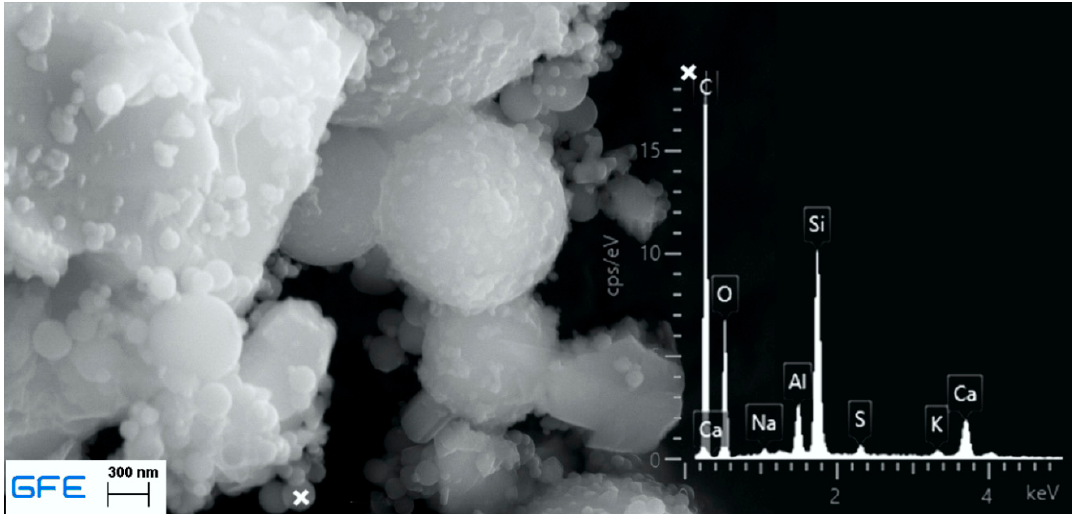
Figure 3. SEM picture and corresponding EDX spectrum of ready dry mix <125 µm, silica fume.